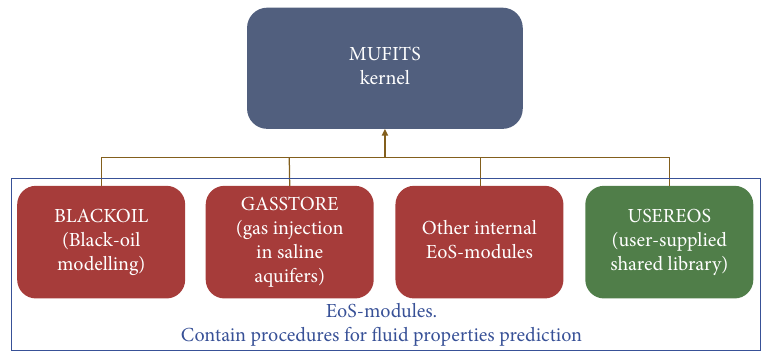
Figure 1: Architecture of MUFITS (modi fi ed after